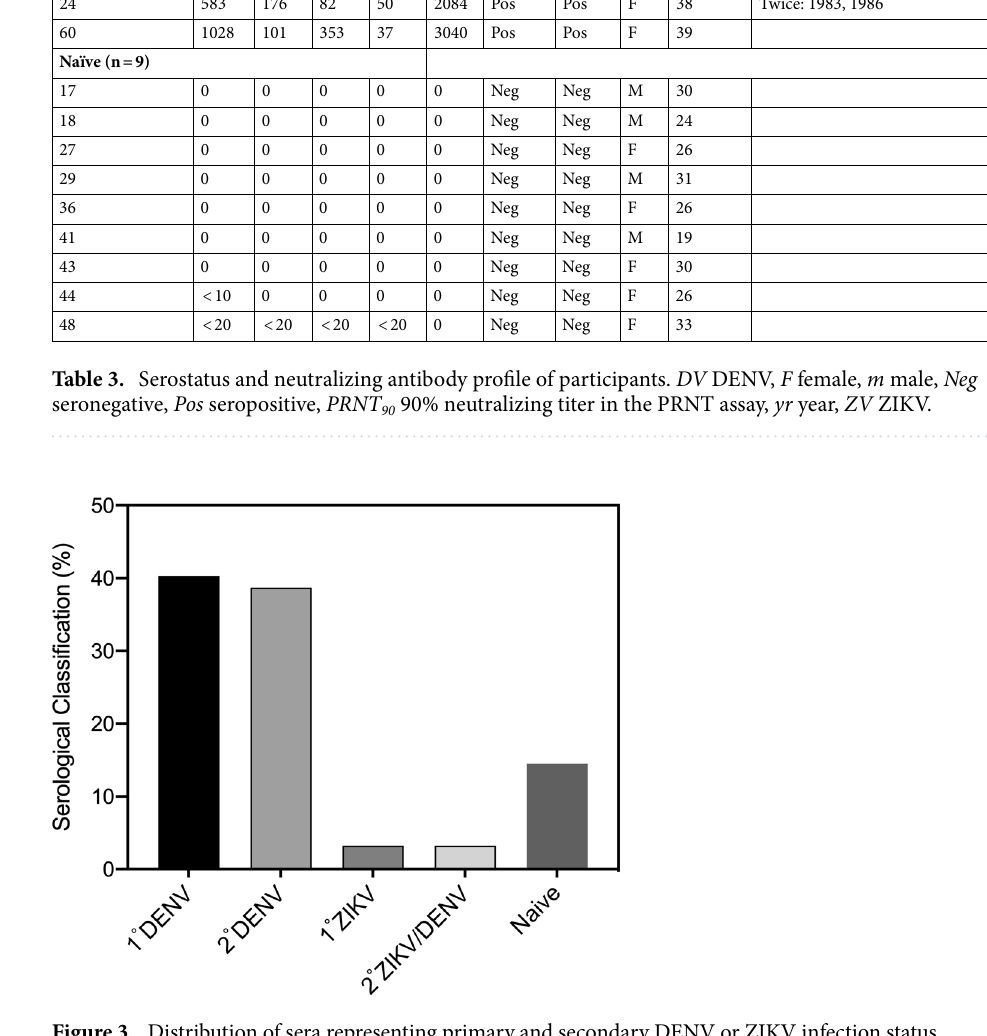
Figure 3. Distribution of sera representing primary and secondary DENV or ZIKV infection status. Seropositivity was defined NT 90 ≥ 20. Primary (1°) and secondary (2°) infections with ZIKV and/or DENV were defined as described in the “Methods” section. The number of samples considered to represent 1° DENV infection, 2° DENV infection, 1° ZIKV infection, 2° ZIKV/DENV infection, and no prior infection (naïve) was 25, 23, 2, 2, and 9,